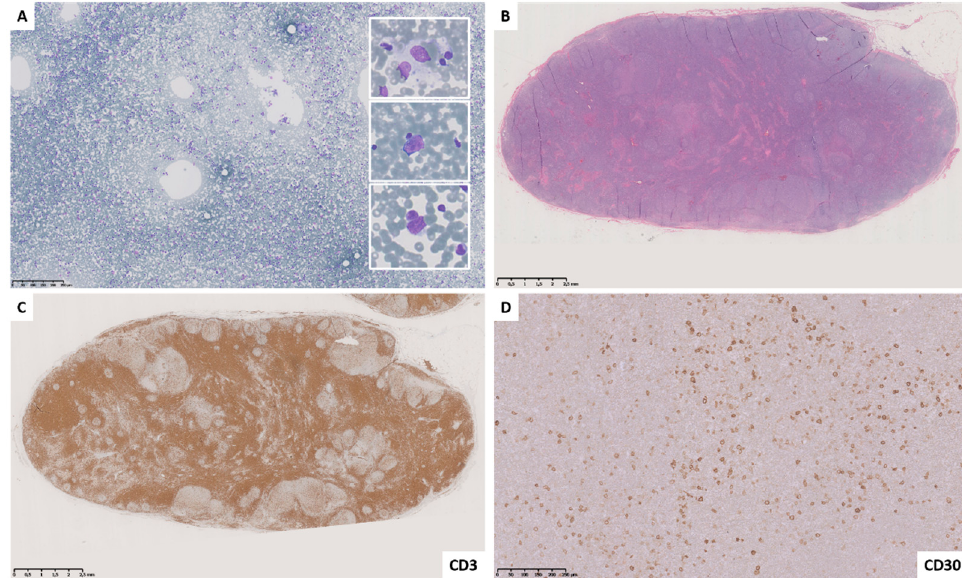
Figure 2. Case L3–4. M, 47 years and history of T-cell rich B-cell lymphoma. Fine needle cytology smear shows a dispersed polymorphous cell population represented by small lymphocytes and few large cells with enlarged and slightly irregular nuclei and scant cytoplasm (( A ) Diff–Quik stain). Histology revealed a benign reactive hyperplasia (( B ) hematoxylin and eosin stain) with interfollicular expansion (( C ) CD3) and numerous CD30-reactive immunoblasts ( D ).